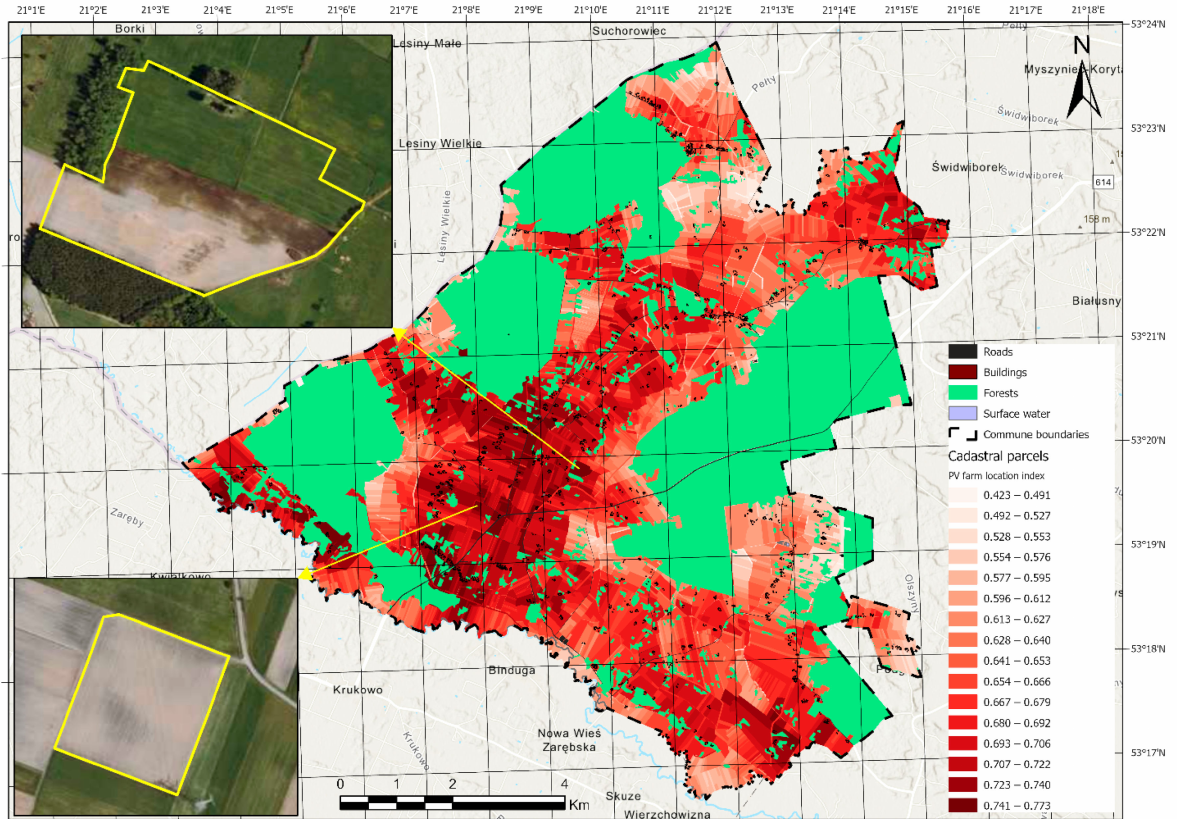
Figure 11. A map of decision alternatives for the selected test area (the commune of